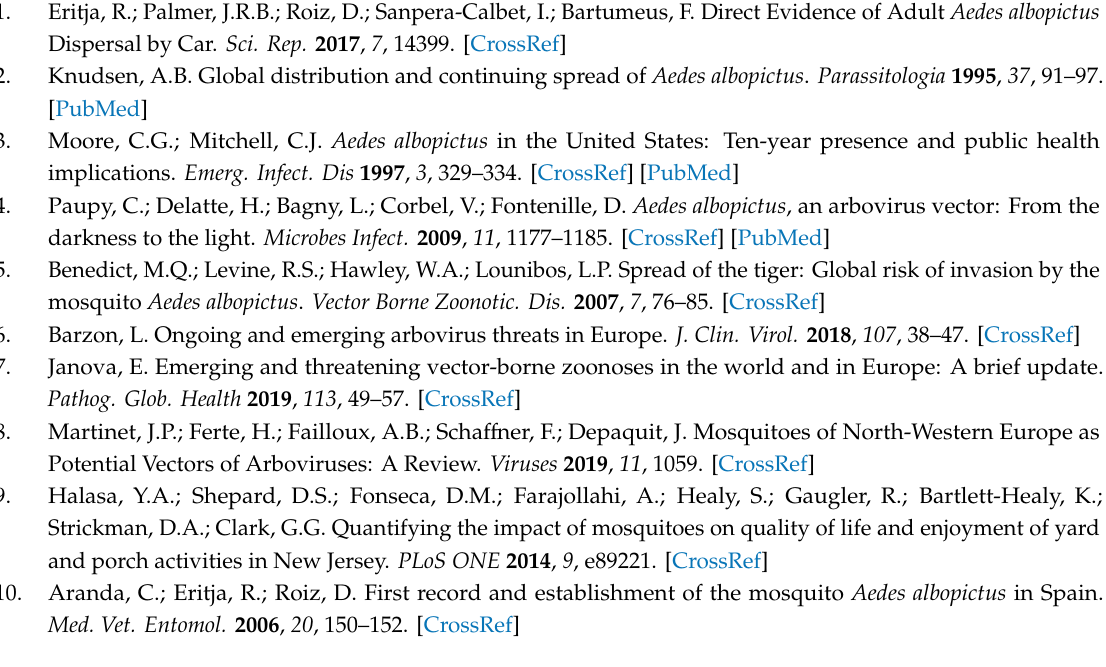
Table S1: Database with the results of the presence of Ae. albopictus eggs obtained in the surveillance programme (2013–2018). Table S2: Number of ovitraps examined and number of positive traps per sampling site and year. Table S3: Data of adult mosquitoes collected and their identification. Table S4: Number of insect bite consultations and consultations per 1000 inhabitants in the Health Counties for the period